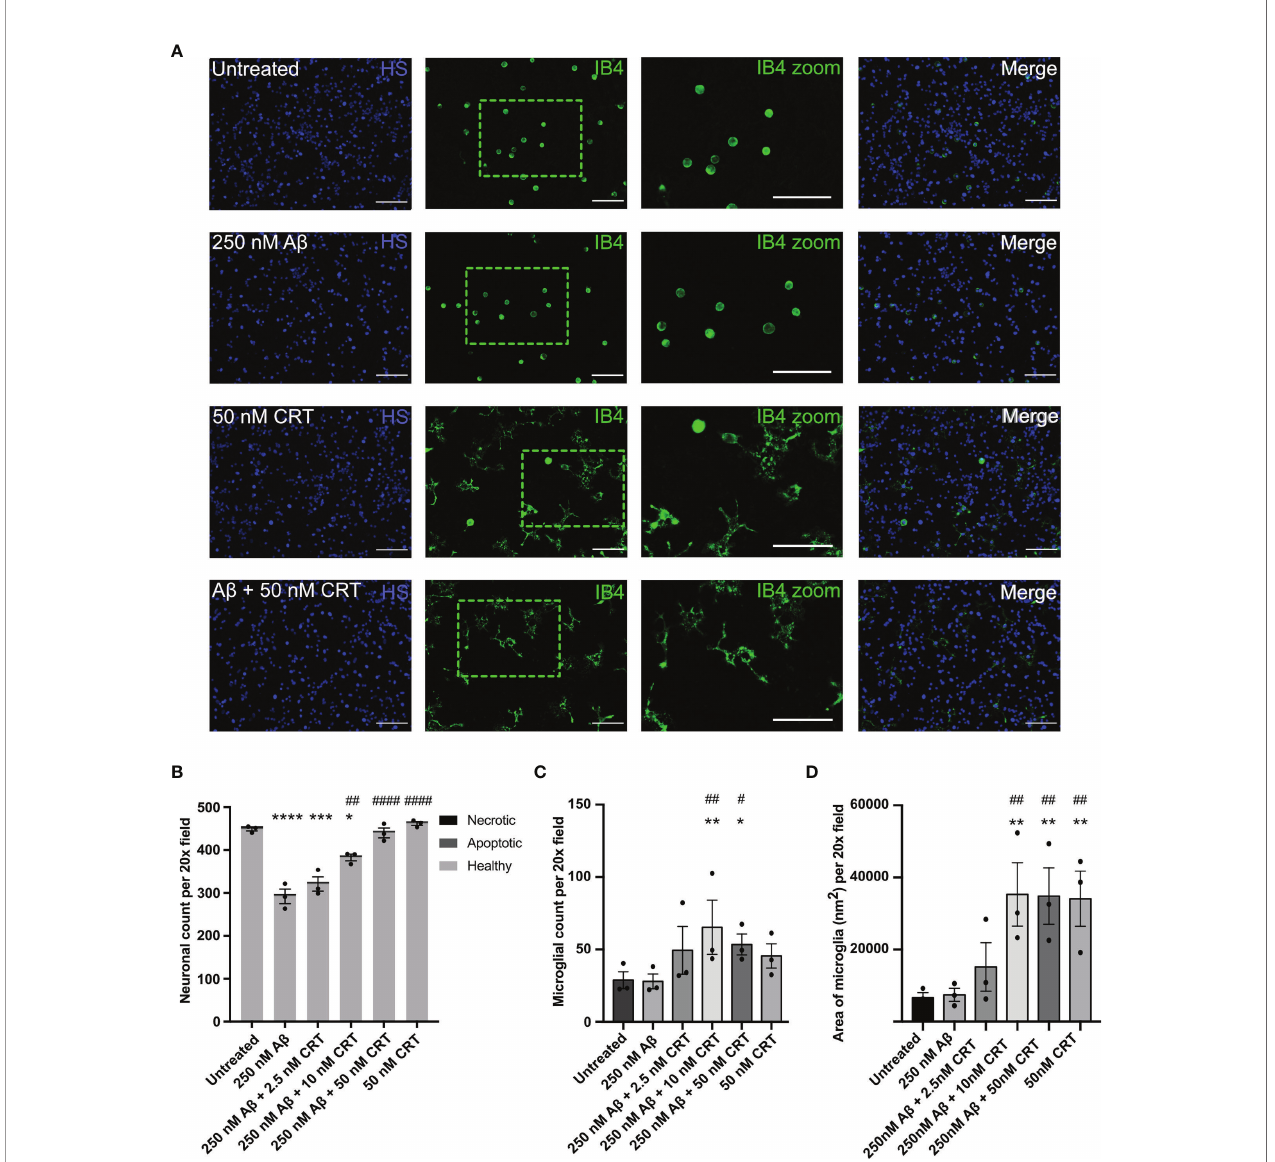
FIGURE 7 | Calreticulin protects against amyloid beta induced neuronal loss. Mixed neuron-glial co-cultures were treated ± monomeric 250 nM A b and ± 2.5 nM, 10 nM or 50 nM calreticulin (CRT) for 72 h at 37 °C. (A) Cultures were stained with isolectin B4 (green, to identify microglia), propidium iodide (red, to identify necrotic cells, not shown), Hoechst 33342 (blue, to identify nuclei and apoptotic cells) and representative, imaged fi elds are shown. Scale bars = 100 µm. (B) Neuronal cell numbers and cell death were quanti fi ed by fl uorescence microscopy. (C) Microglial cell numbers were quanti fi ed by fl uorescence microscopy. (D) Microglial area was quanti fi ed as area of fi eld stained with IB4. Data presented as mean neuronal count, microglial count, or area of microglia, with error bars representing the SEM of 3 independent experiments. Statistical comparisons were made by one-way ANOVA. Asterisk (*) indicate signi fi cance compared to untreated control (*p<0.05, **p<0.01, ***p<0.001, ****p<0.0001). Hash (#) indicate signi fi cance compared to A b only ( # p<0.05, ## p<0.01, ####